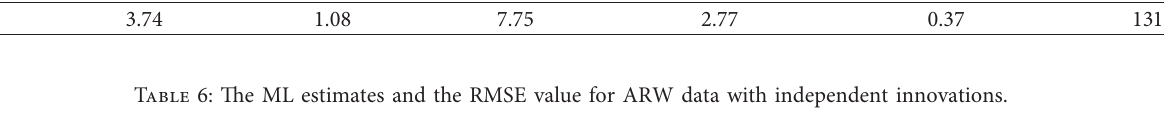
) from normal and SN models. (b) Exact and estimated values of data from normal and SN t